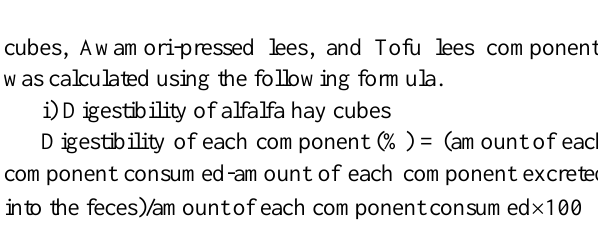
Experiment 2: Use of Awamori-pressed lees and Tofu weaning to maturity